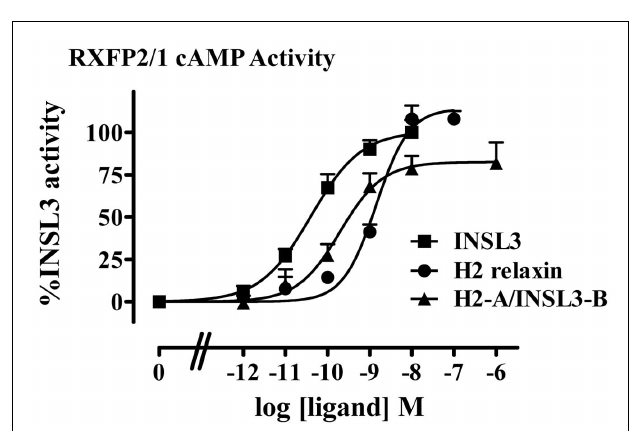
FIGURE 3 | cAMP activity of H2-A/INSL3-B compared to INSL3 and H2 relaxin at the RXFP2/1 chimeric receptor measured utilizing a pCRE– β -galactosidase reporter gene assay. Data are expressed as the percentage INSL3 maximum activity and are pooled data from at least three experiments with triplicate determinations within each assay.